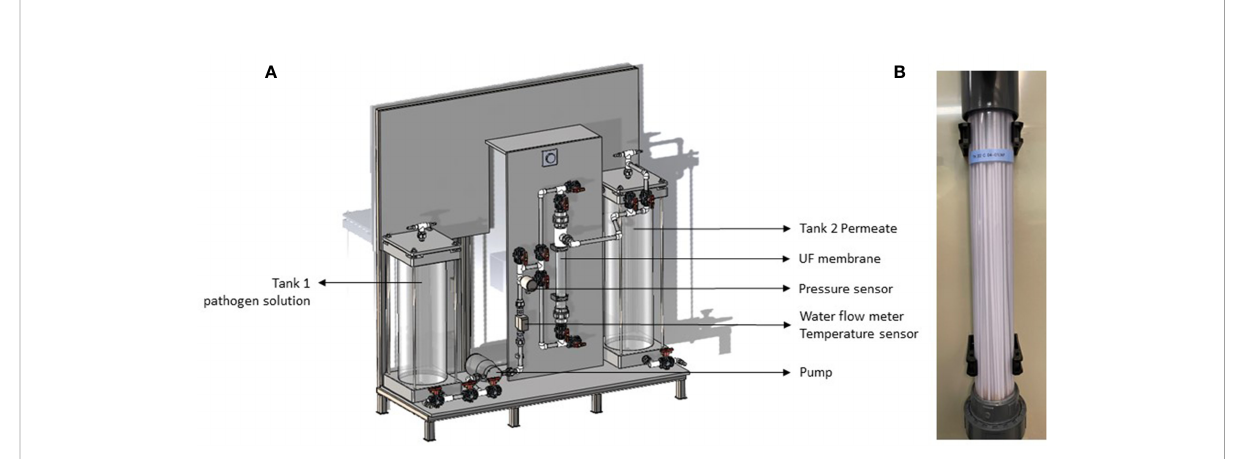
FIGURE 1 Sketch of the ultra fi ltration membrane bench-scale unit (A) and picture of the membrane tested (B)